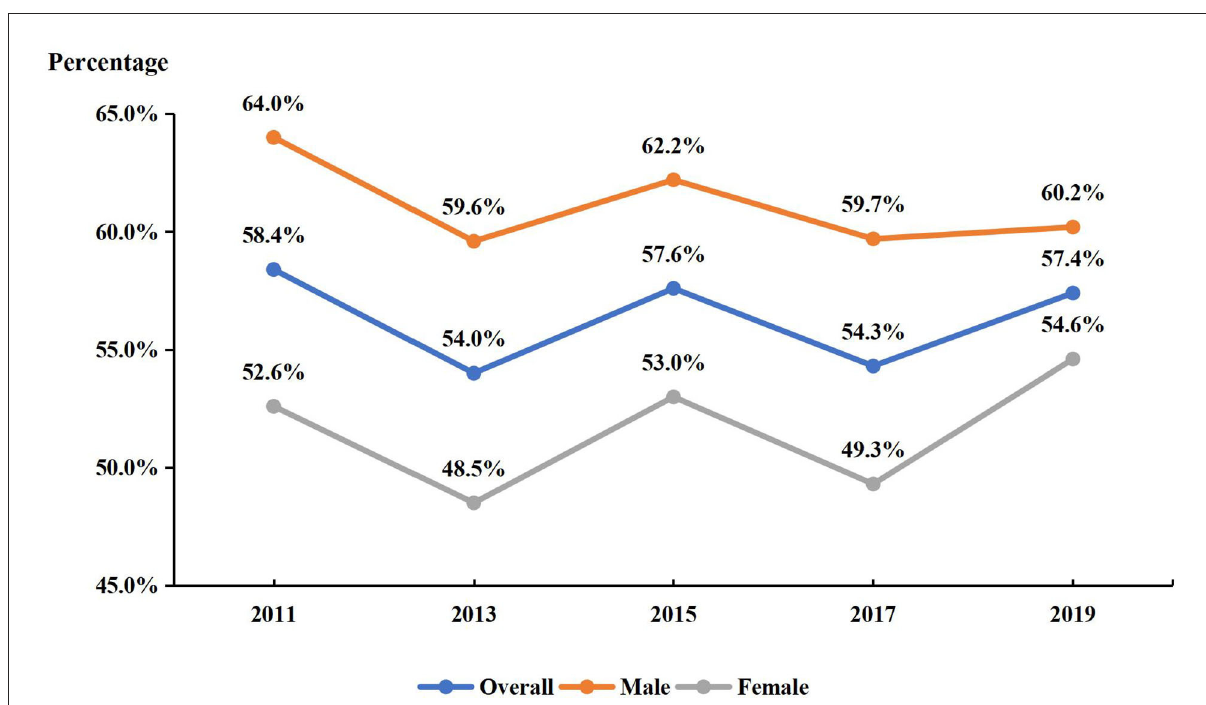
FIGURE1 Prevalence of participating in at least one sports team over the past 12 months in the sample (overall and by sex) between 2011 and 2019. For the overall sample, models were controlled for sex, grade, and race/ethnicity. For sample by sex, models were controlled for grade and